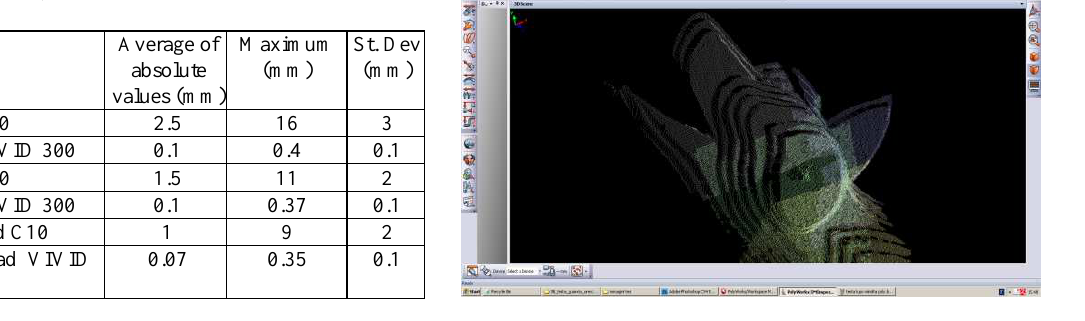
Table 2. Deviations for the statuary group St. George and the